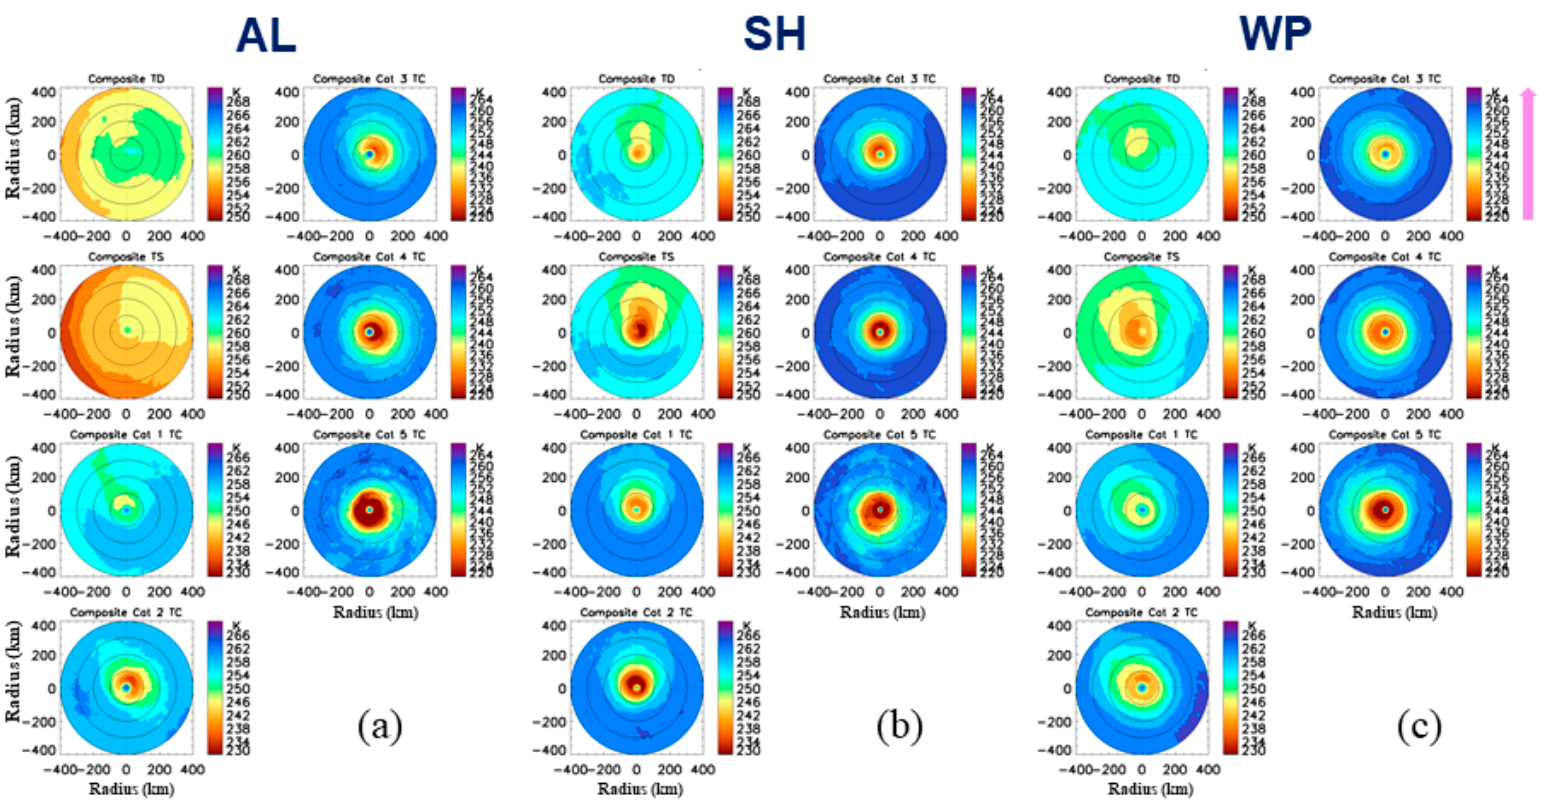
Figure 7. Distributions of TBs at 89H GHz of the composite storms relative to the storm motion direction at tropical depression (TD), tropical storm (TS), and Cat 1–5 TCs during 1987–2012 for ( a ) Atlantic (AL), ( b ) Southern Hemisphere (SH) and ( c ) West Pacific (WP) basin. The pink vertical arrow indicates direction of TC movement.